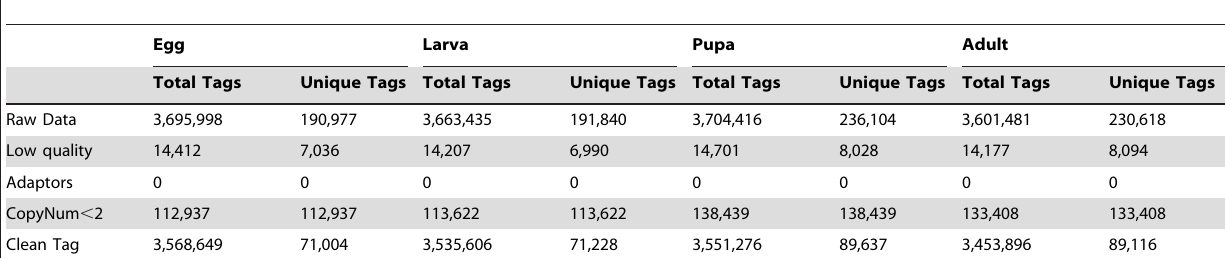
Table 3. DGE-tag raw data and clean tag amount in the four developmental stages of O. furnacalis.